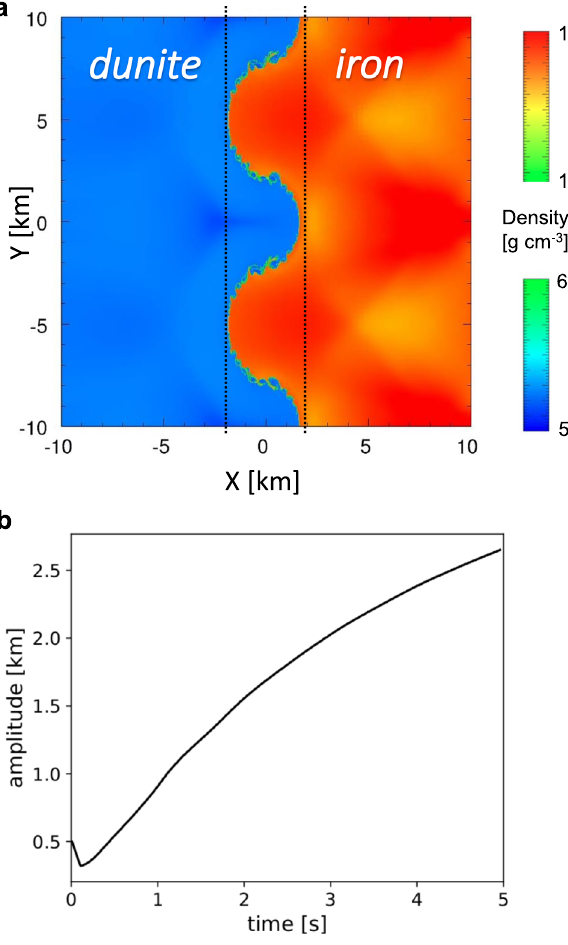
Fig. 1 Large scale dunite-iron impact induces interface instability. a Map of densities of a corrugated iron plate (red) impacting a fl at dunite target (blue) at U impact = 10.5 km/s, shown 2.39 s after impact, as calculated using the CTH code 9 . The potential mixing zone is marked between dashed lines. The initial topography has amplitude a 0 = 0.5 km and wavelength λ = 10 km, and the model domain extends 2 λ = 20 km in the perpendicular ( y ) direction. b Calculated amplitude of the interface between iron and dunite over time. After a brief initial compression with a minimal amplitude of a – U U 0 (1 particle / impact ), the interface amplitude increases monotonically, thereby enlarging the potential mixing zone ( U particle is particle velocity). As the interface does not remain symmetrical with time, its amplitude is taken to be a ( t ) = ( max crest – min trough )/2.